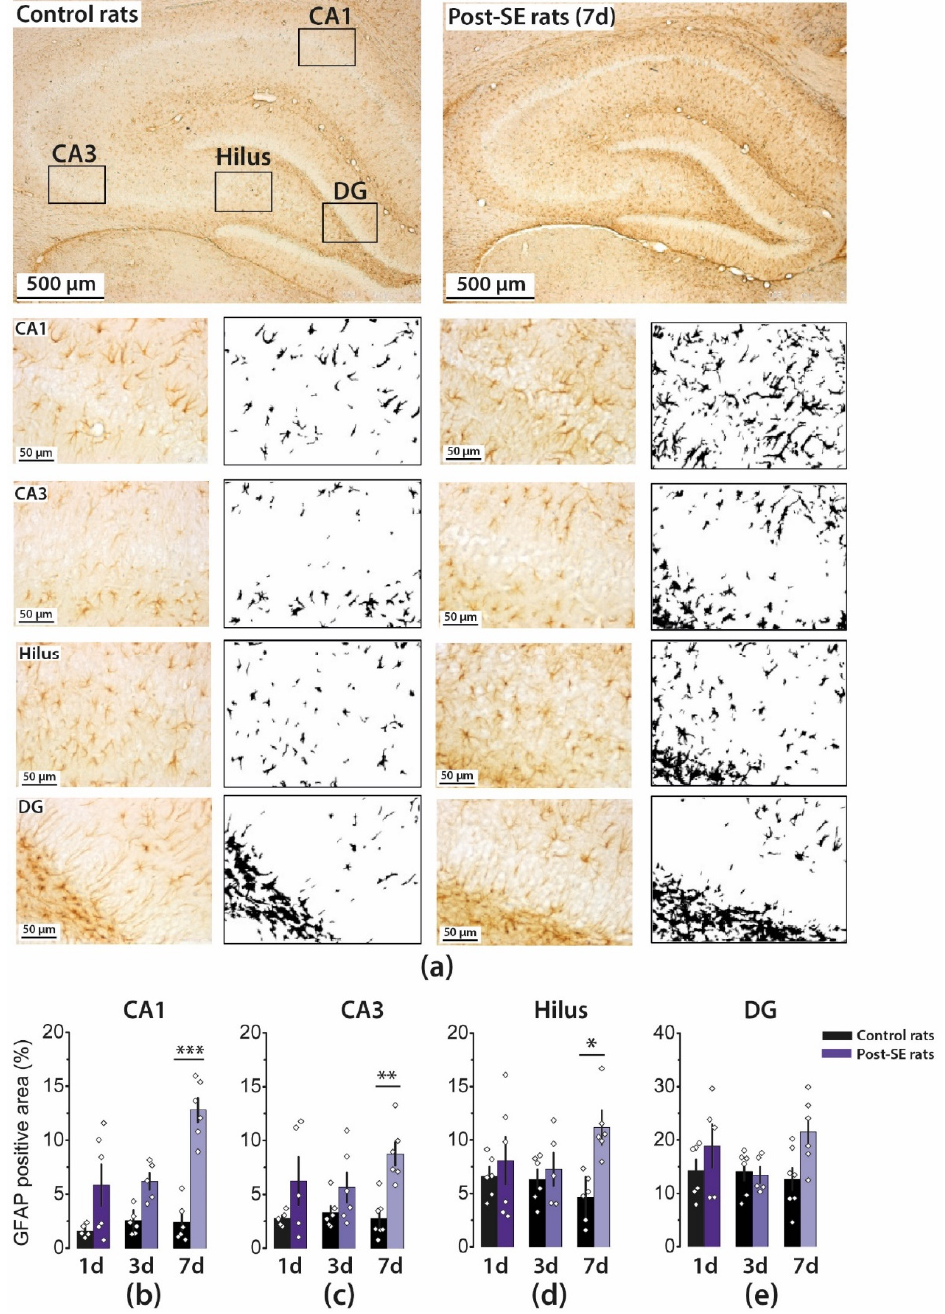
Figure 2. Astrogliosis in the rat hippocampus following pilocarpine-induced SE. ( a ) Immunohistochemistry targeting glial fibrillary acidic protein (GFAP) was used for the detection of astrocytes. Representative images of hippocampal sections with GFAP-positive cells and their corresponding black–white masks, which were obtained with ImageJ software and used for area counting (upper panels: ×5 magnification and lower panels: ×40 magnification). The averaged GFAP-positive areas in different hippocampal regions: CA1 ( b ), CA3 ( c ), hilus ( d ), and DG ( e ). Five to seven animals were in each group. The diamonds show the individual values for each rat. The columns indicate average values, and error bars show standard errors of the means. Two-way ANOVA was performed to determine the effects of SE, time after SE, and the interaction of these factors: CA1 (SE: F 1, 28 = 48, p < 0.001; time: F 2, 28 = 7.6; p < 0.01; SE × time: F 2, 28 = 6.1, p < 0.01); CA3 (SE: F 1, 29 = 17.4, p < 0.001; time: F 2, 29 = 0.82; p = 0.45; SE × time: F 2, 29 = 1.4, p = 0.26); hilus (SE: F 1, 29 = 7.3, p < 0.05; time: F 2, 29 = 0.32; p = 0.73; SE × time: F 2, 29 = 2.7, p = 0.09); DG (SE: F 1, 29 = 4.6, p < 0.05; time: F 2, 29 = 1.1; p = 0.36; SE × time: F 2, 29 = 2.0, p = 0.16). * p <0.05, ** p < 0.01, *** p < 0.001 (Tukey’s post hoc test ).